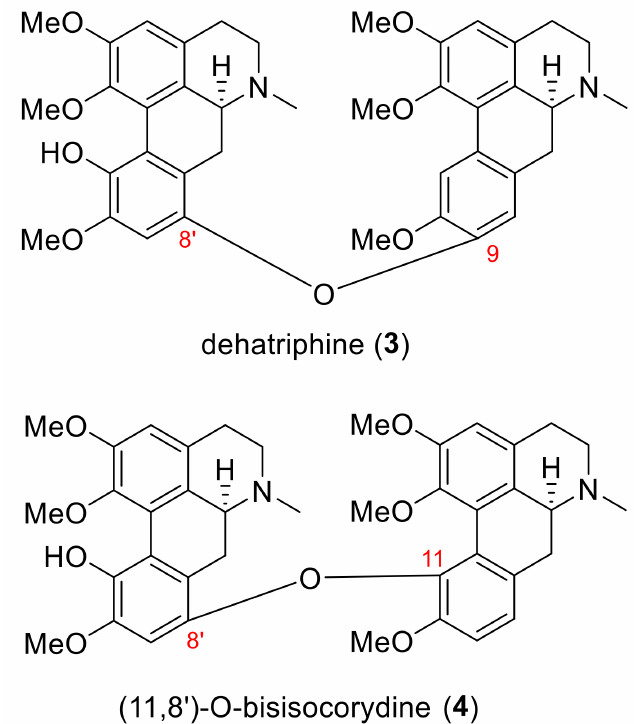
Figure 2. Bisaporphines with ether linkage at the C8